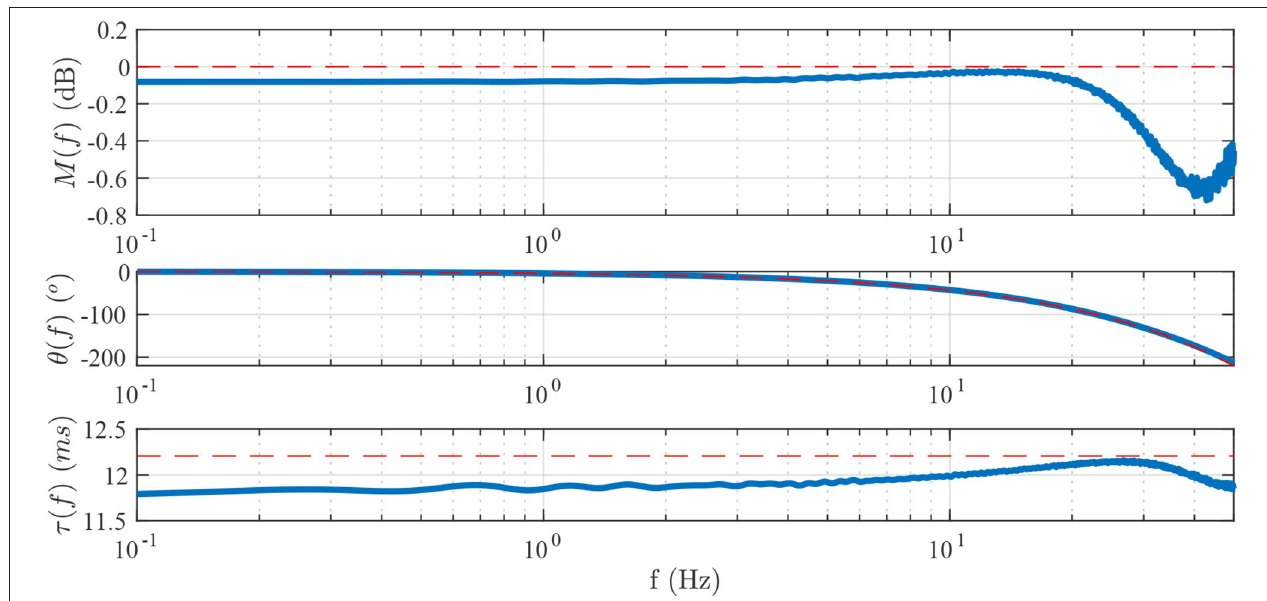
FIGURE 10 | Frequency response of the cascade in the [0.1,100] Hz band ( Top : amplitude, Middle : phase), and associated phase delay (Bottom) . The dashed red lines correspond to the frequency response and phase delay of the perfect digital impulse response with 1